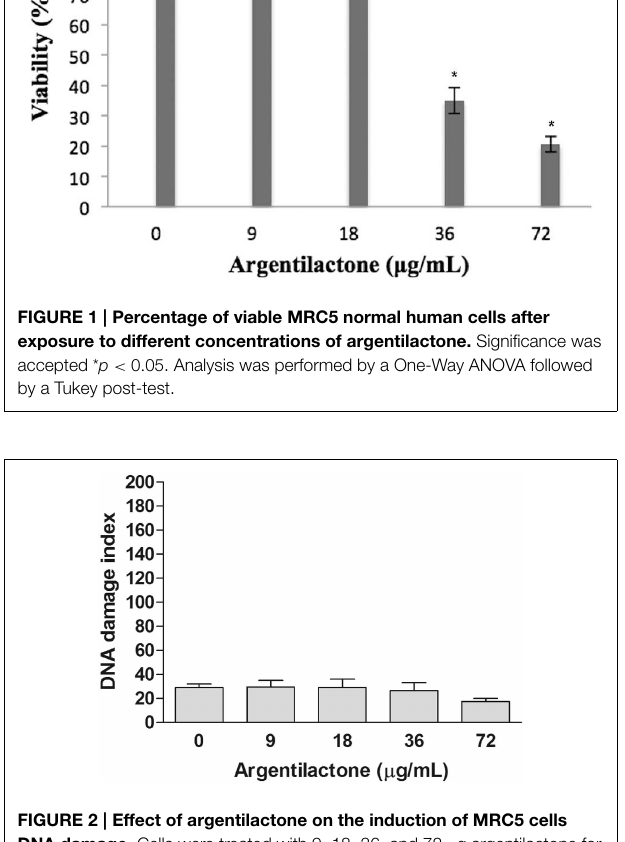
Frontiers in Microbiology |